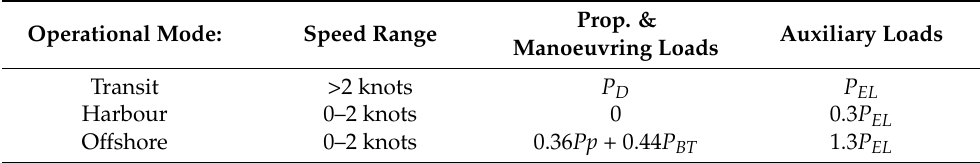
Table 7. Propulsion, manoeuvring and auxiliary loads during different modes. Operational